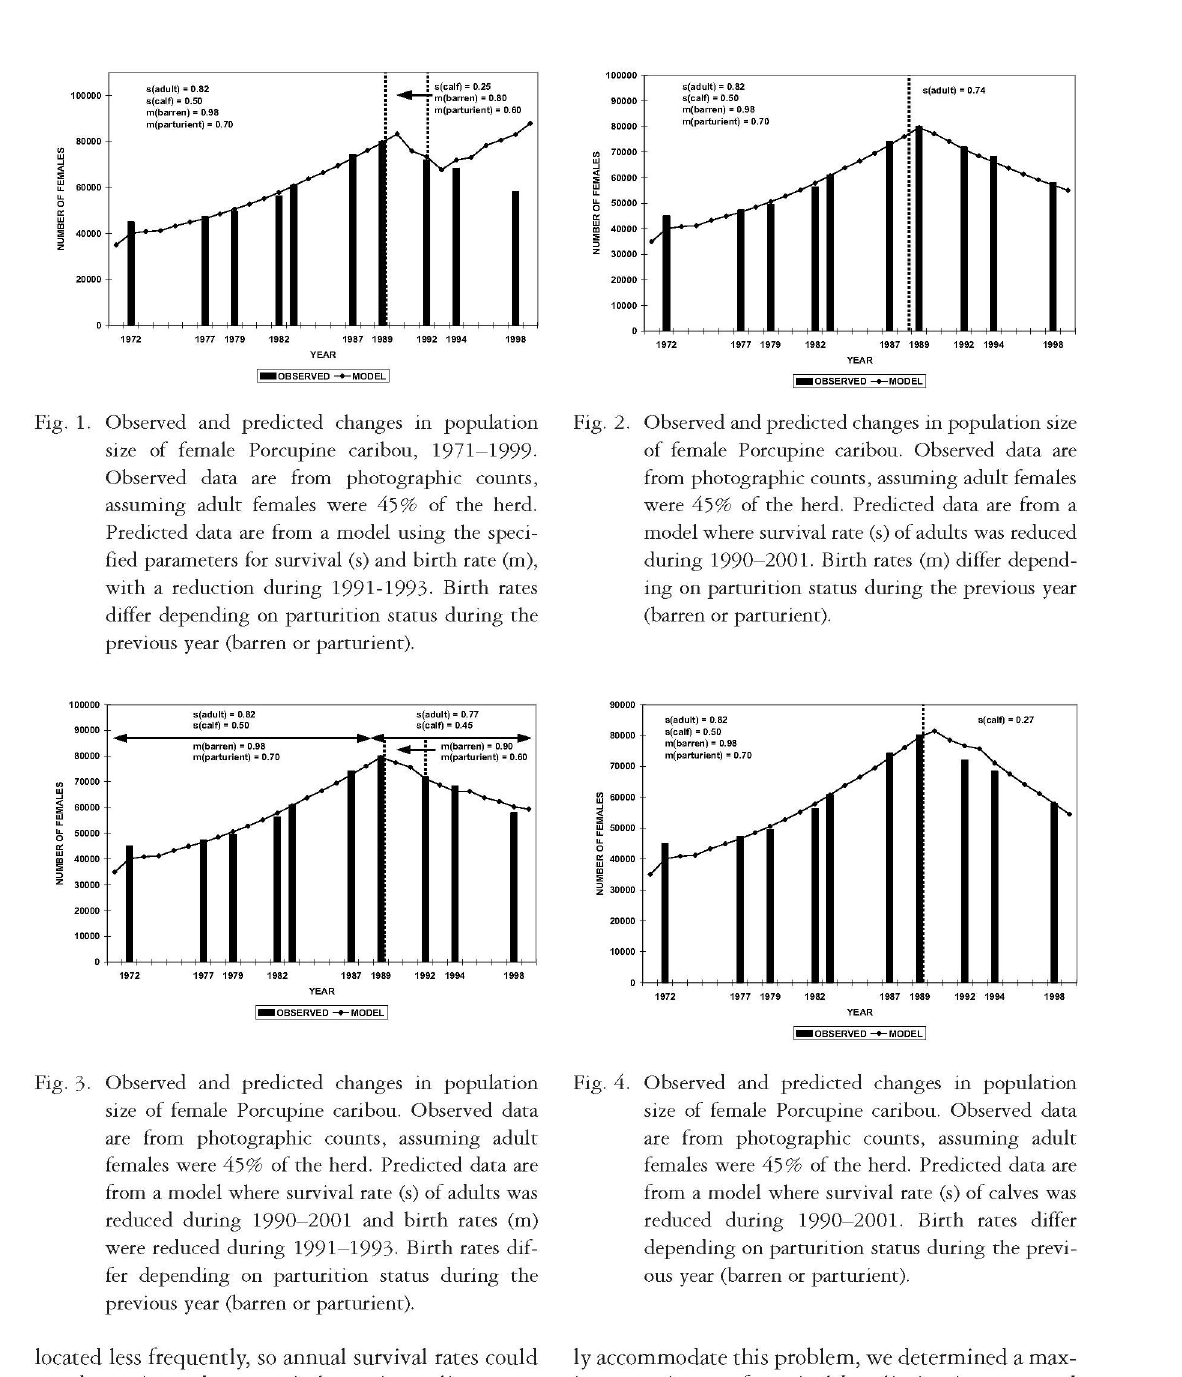
Fig. 4. Observed and predicted changes in population size of female Porcupine caribou. Observed data are from photographic counts, assuming adult females were 45% of the herd. Predicted data are from a model where survival rate (s) of calves was reduced during 1990-2001. Birth rates differ depending on parturition status during the previ¬ ous year (barren or